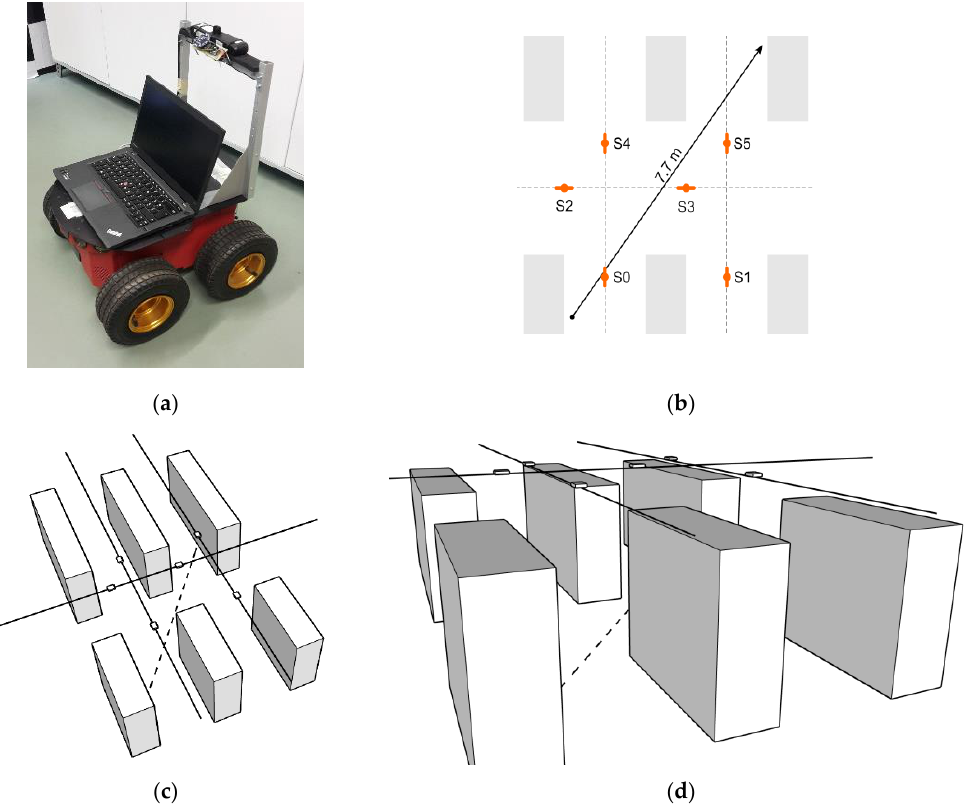
Figure 18. ( a ) Pioneer AT-3 mobile robot platform with IR transmitter attached to its handle; ( b ) Static / Mobile-2D experiment setup (WSN topology and movement trajectory used in E3); ( c , d ) 3D models of the E3 setup: six AoA sensors are placed above the shelf mock-ups made of cardboard